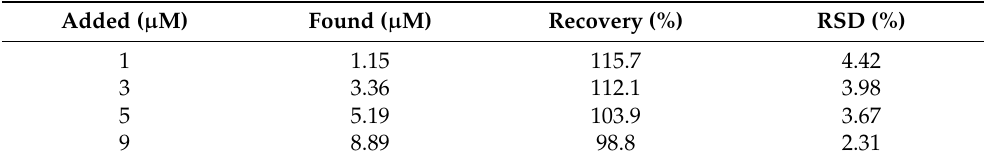
Table 3. Determination of nitrite level in water from a well with a C-SPE coated by MAPLE with CNT-Chit-FePc